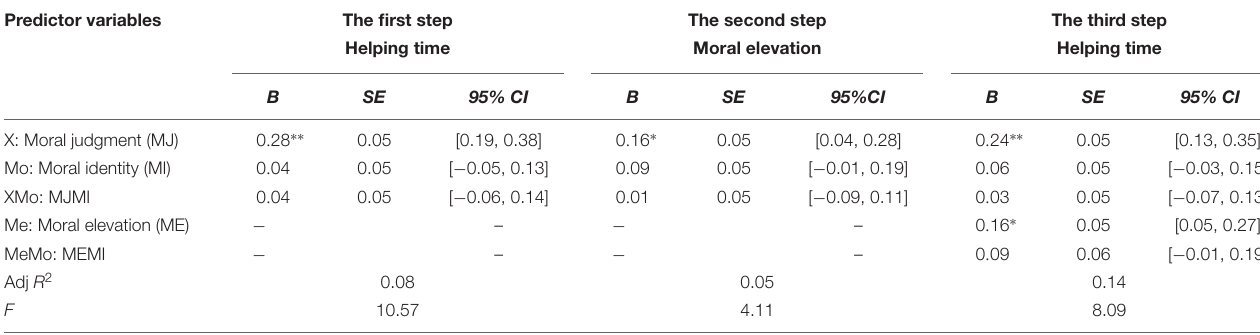
TABLE 4 | Least squares regression results for men. Predictor variables